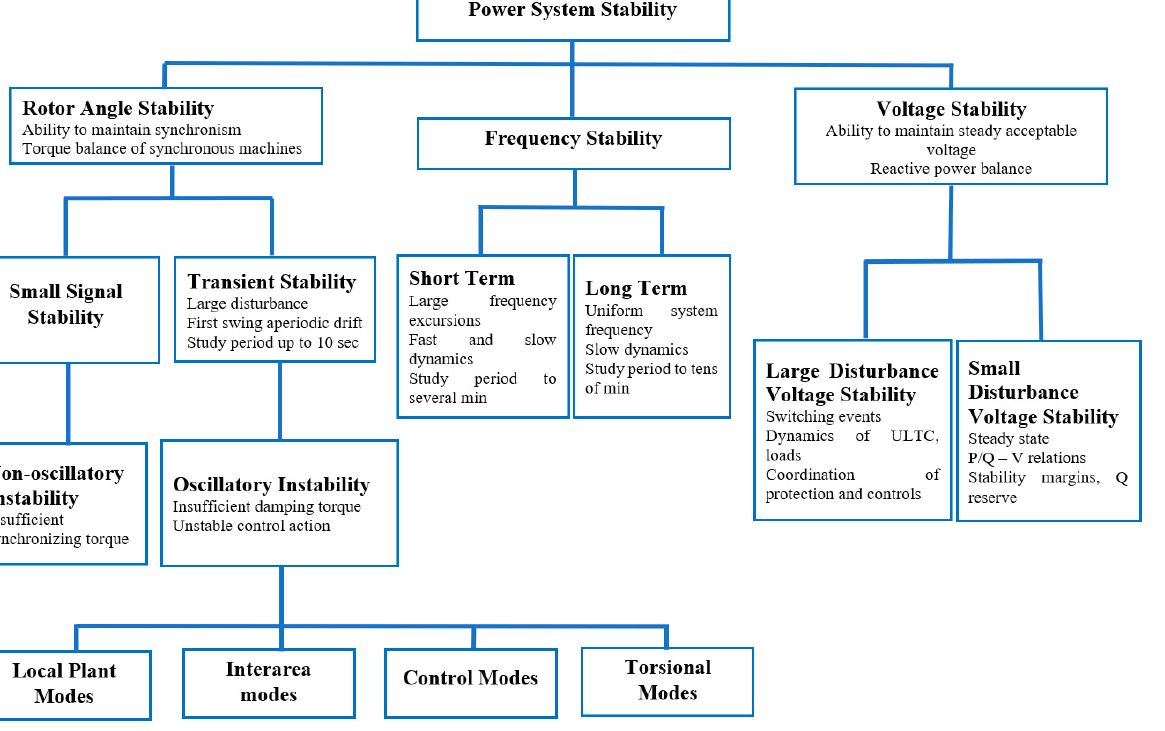
Figure 1. Stability classification of a power system.